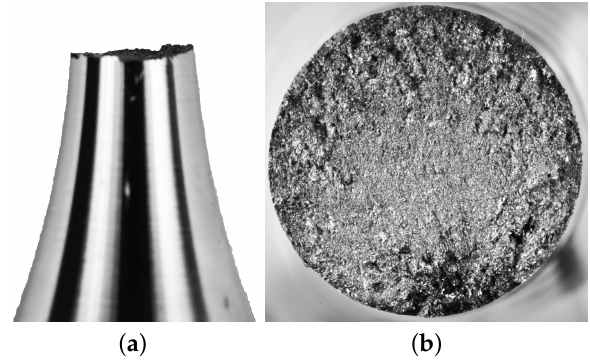
Figure 10. Final failure surface in case of specimens extracted from Bar B . ( a ) Side view; ( b ) Upper